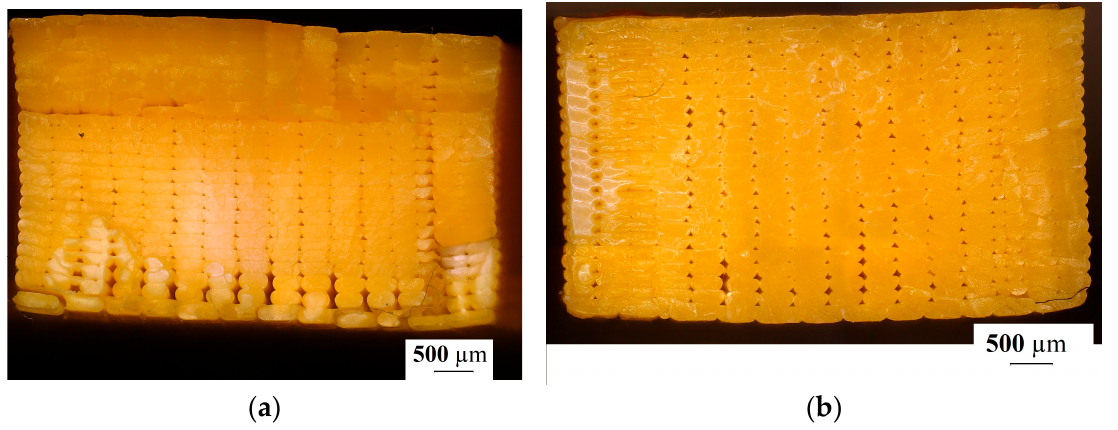
Figure 9. The ruptured surface of the horizontally printed test specimen after the tensile test. ( a ) A specimen that did not undergo heat treatment; ( b ) a specimen heat-treated at 65 °C. The ruptured surfaces show the heat treatment effects. The surfaces had some brittle fractures (Figure 9c). The 3D pictures of the ruptured surfaces better show the difference between the heat- treated and non-heat-treated specimens (Figure 10). The heat treatment temperature was 65 ◦ C.